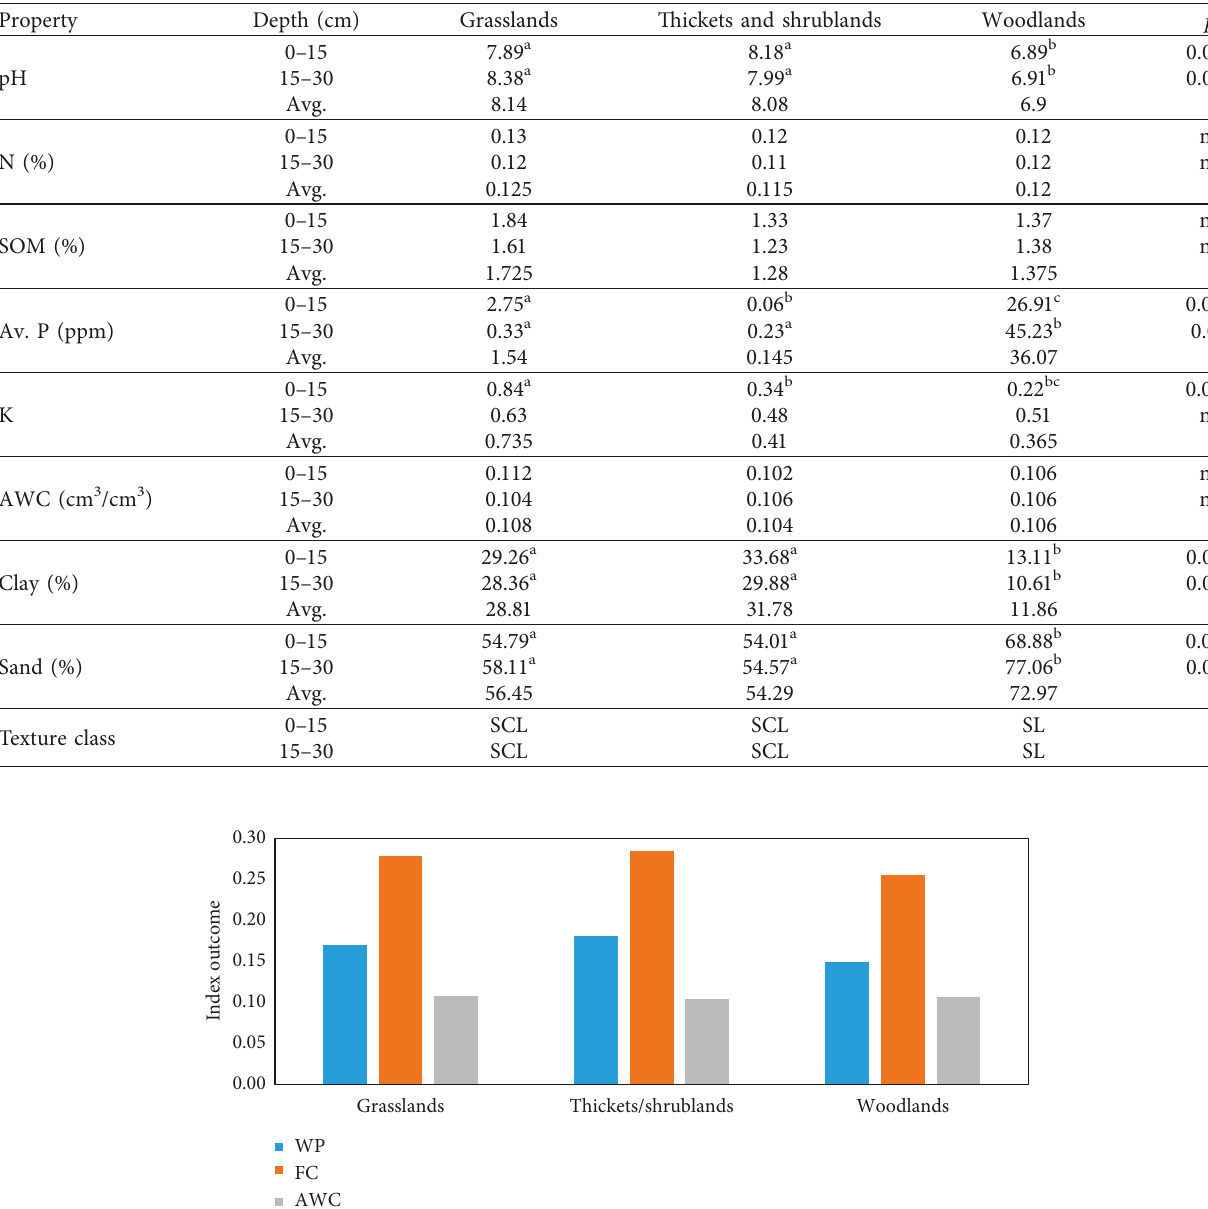
Table 1: Summary of chemical and physical soil properties characteristics.